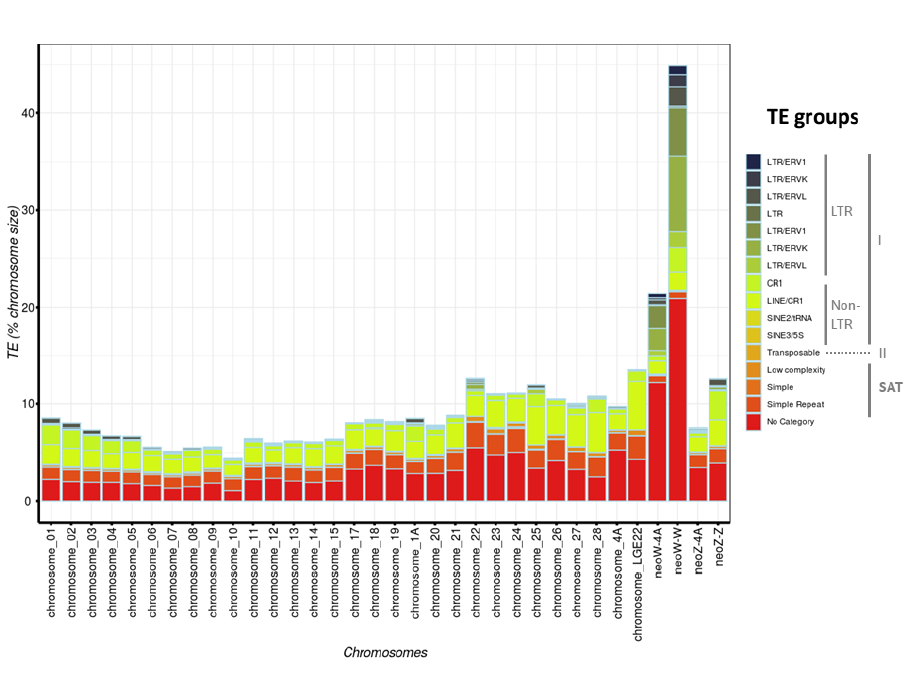
Figure S9. TE density for each chromosome and for each RepBase TE family. Class I TE elements were categorized following the two subclasses: LTR and non-LTR